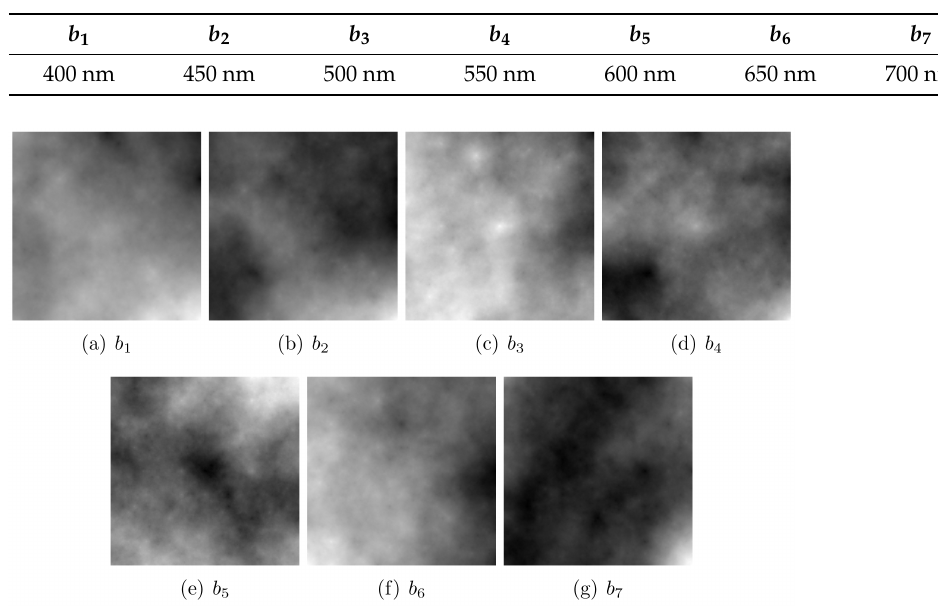
Table 1. The arbitrary mapping between the seven generated bands and the corresponding wave- lengths.